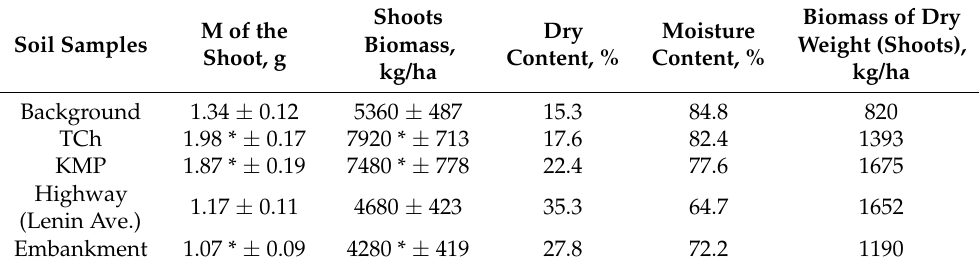
Table 5. Formation of Echinochloa frumentacea biomass on the soils with polymetal anomalies.